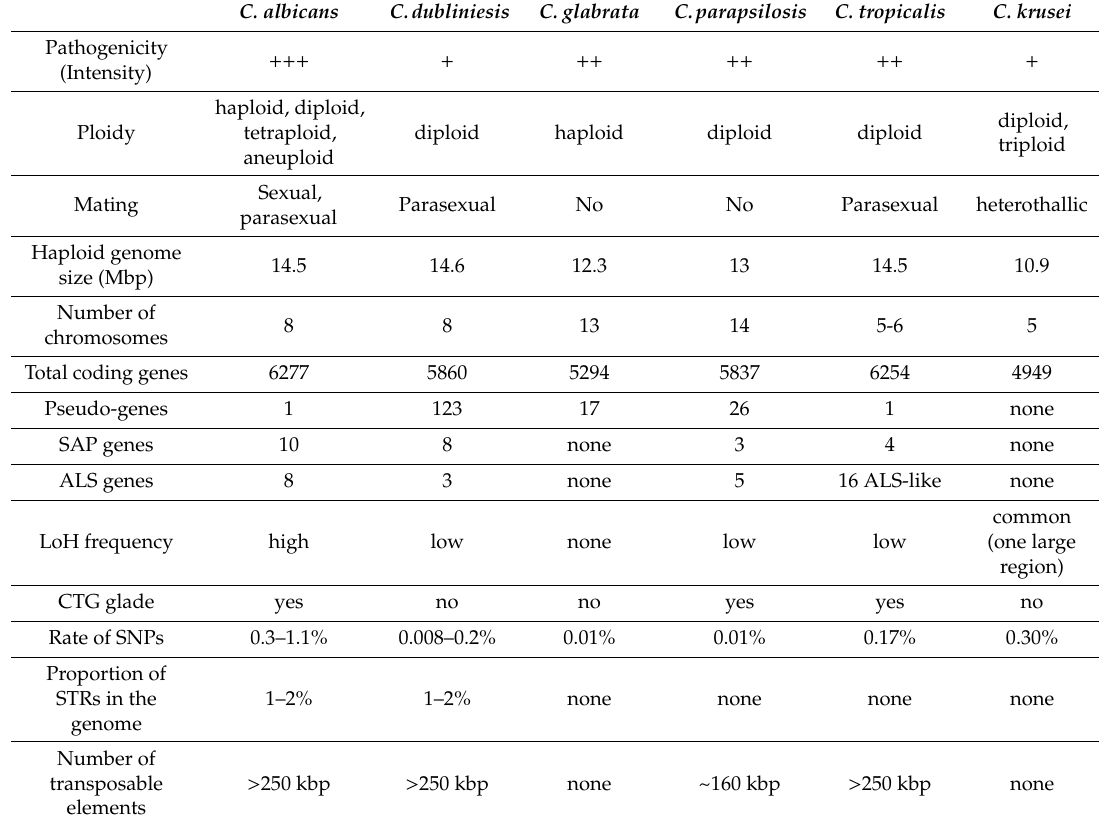
Table 1. Genetic features of Candida spp.